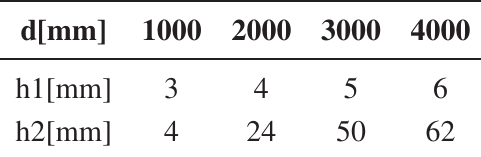
Table 1. Diffuse height of laser beam with respect to distance and scanning